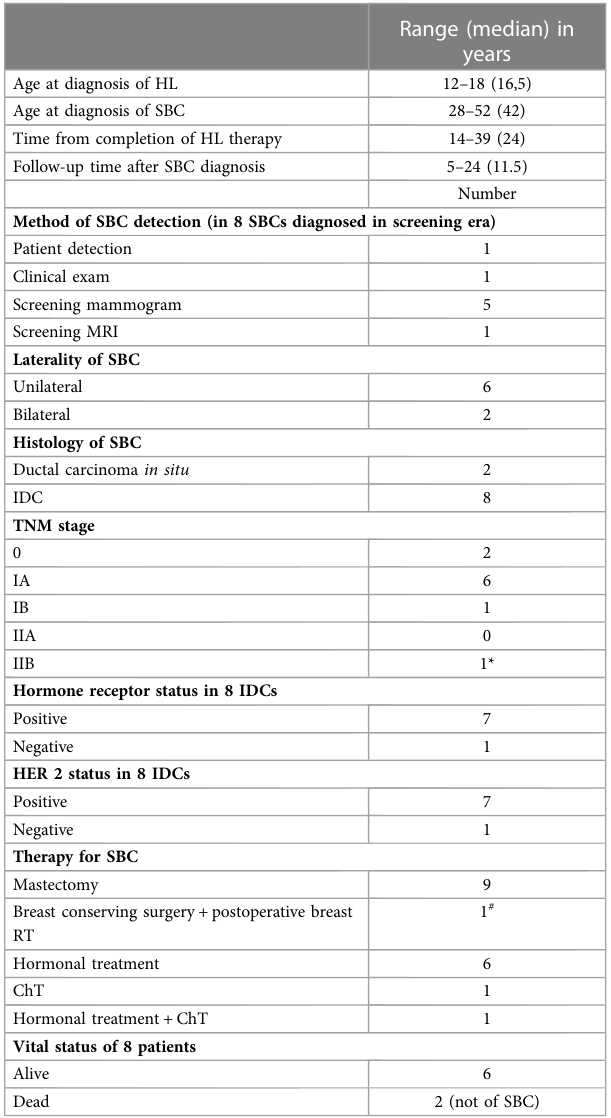
TABLE 2 Characteristics of ten SBCs in 8